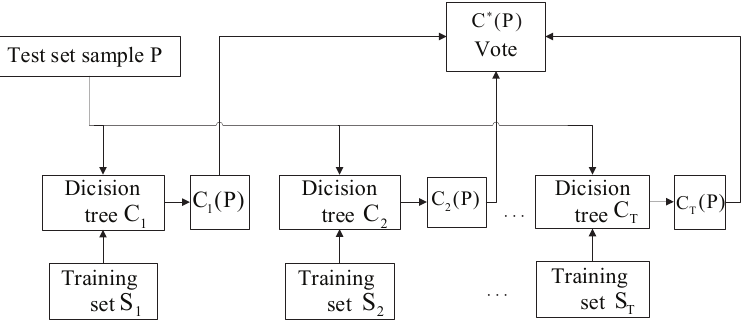
Figure 13. Bagging